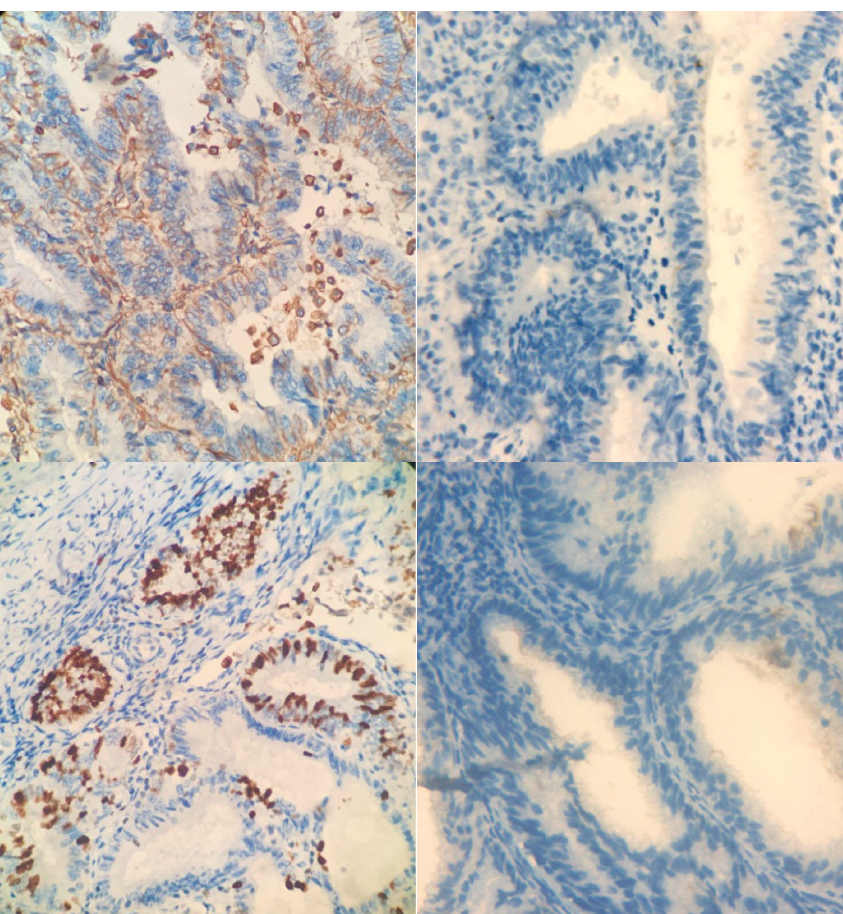
Figure 1: Expression of SPHK1 and VEGF in the tissues of patients in each group. Left-top: The expression of SPHK1 in endometrial carcinoma was positive ( × 200). Right-top: The expression of SPHK1 in endometrium ( × 200). Left-bottom: VEGF expression in endometrial atypical hyperplasia group ( × 400). Right-bottom: The expression of VEGF in endometrium was negative ( × 400). Table 1: Comparison of the expression of SPHK1 and VEGF between the two groups.